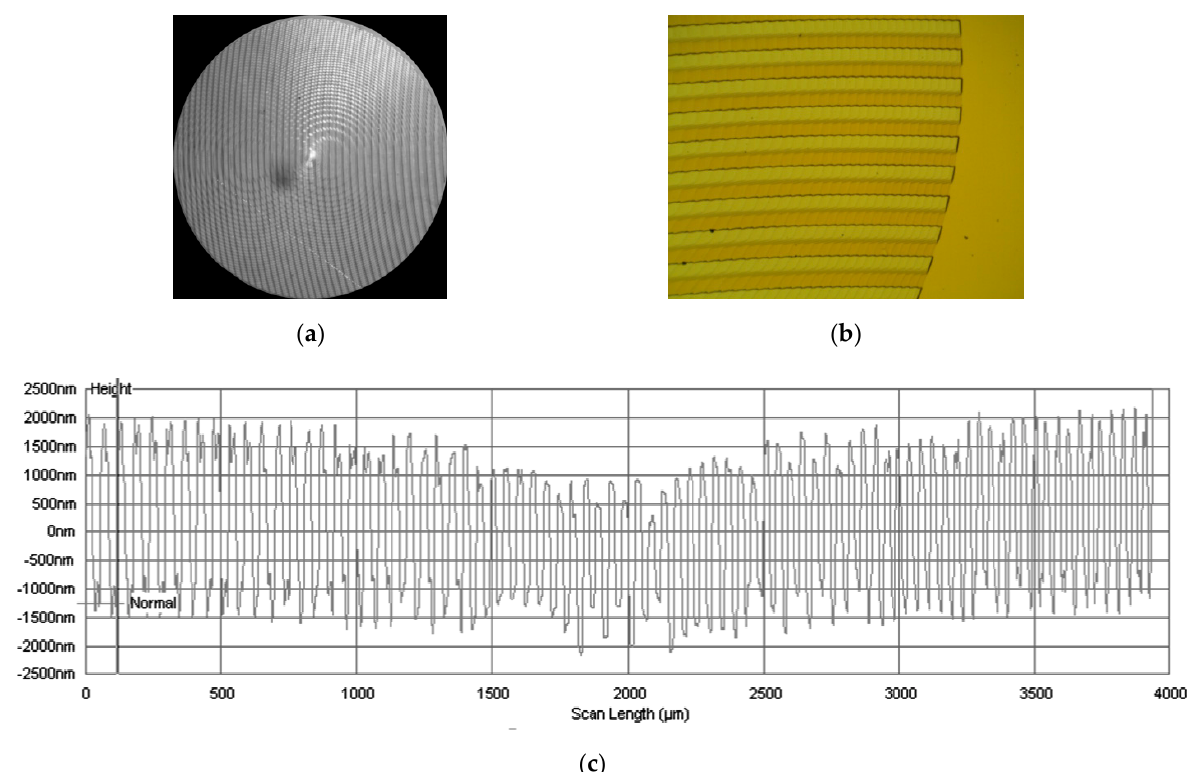
Figure 2. An optical microscope image of ( a ) an SDL (900 nm, 970 nm), ( b ) an SDL fragment with fine structure (900 nm, 970 nm), and ( c ) a profilogram of the SDL measured along the lens (900 nm, 970 nm) symmetry axis using a Tencor pro- filer.